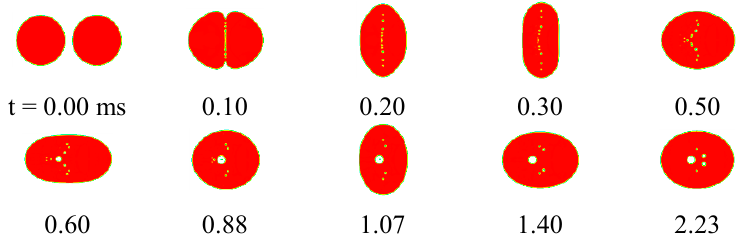
Figure 8. Time evolution for coalescence